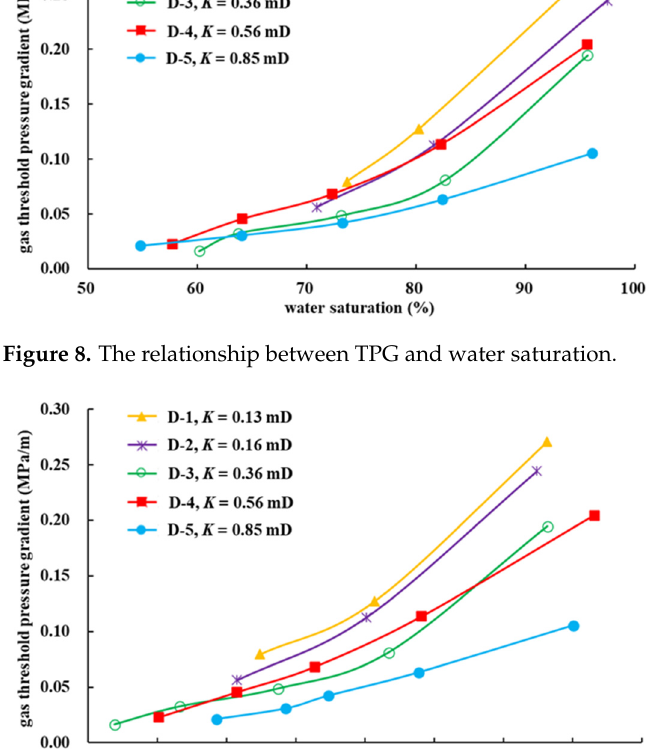
Figure 8. The relationship between TPG and water saturation.